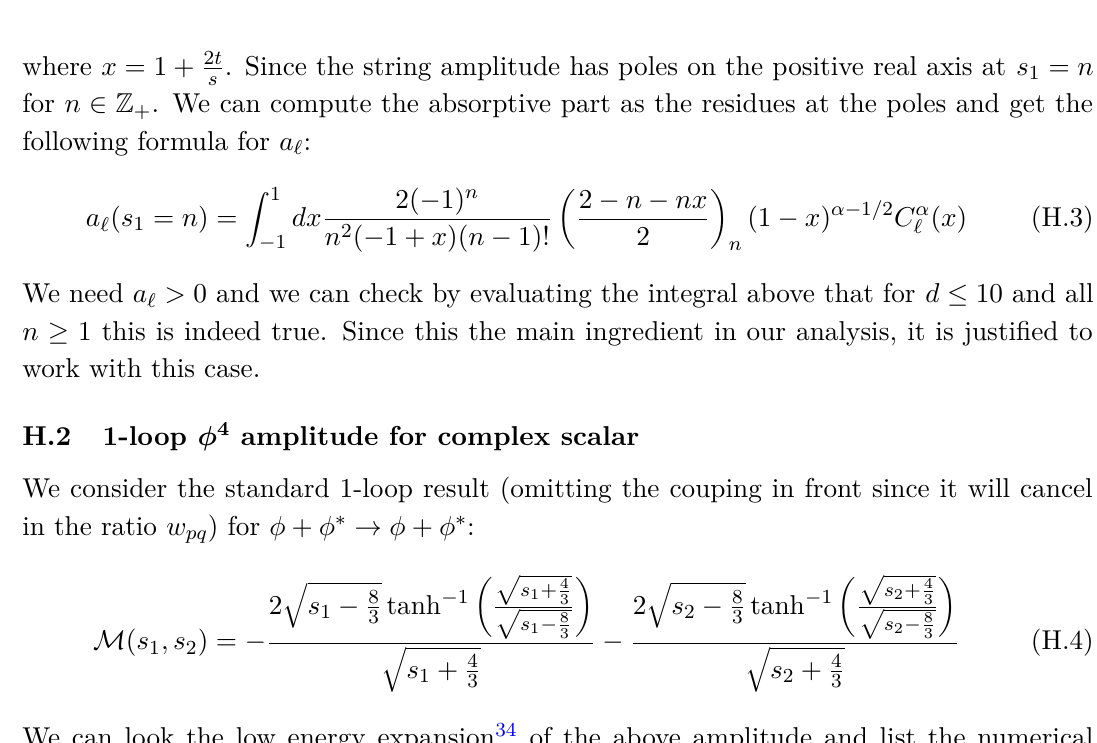
Table 4. The W p,q of the pole subtracted open string